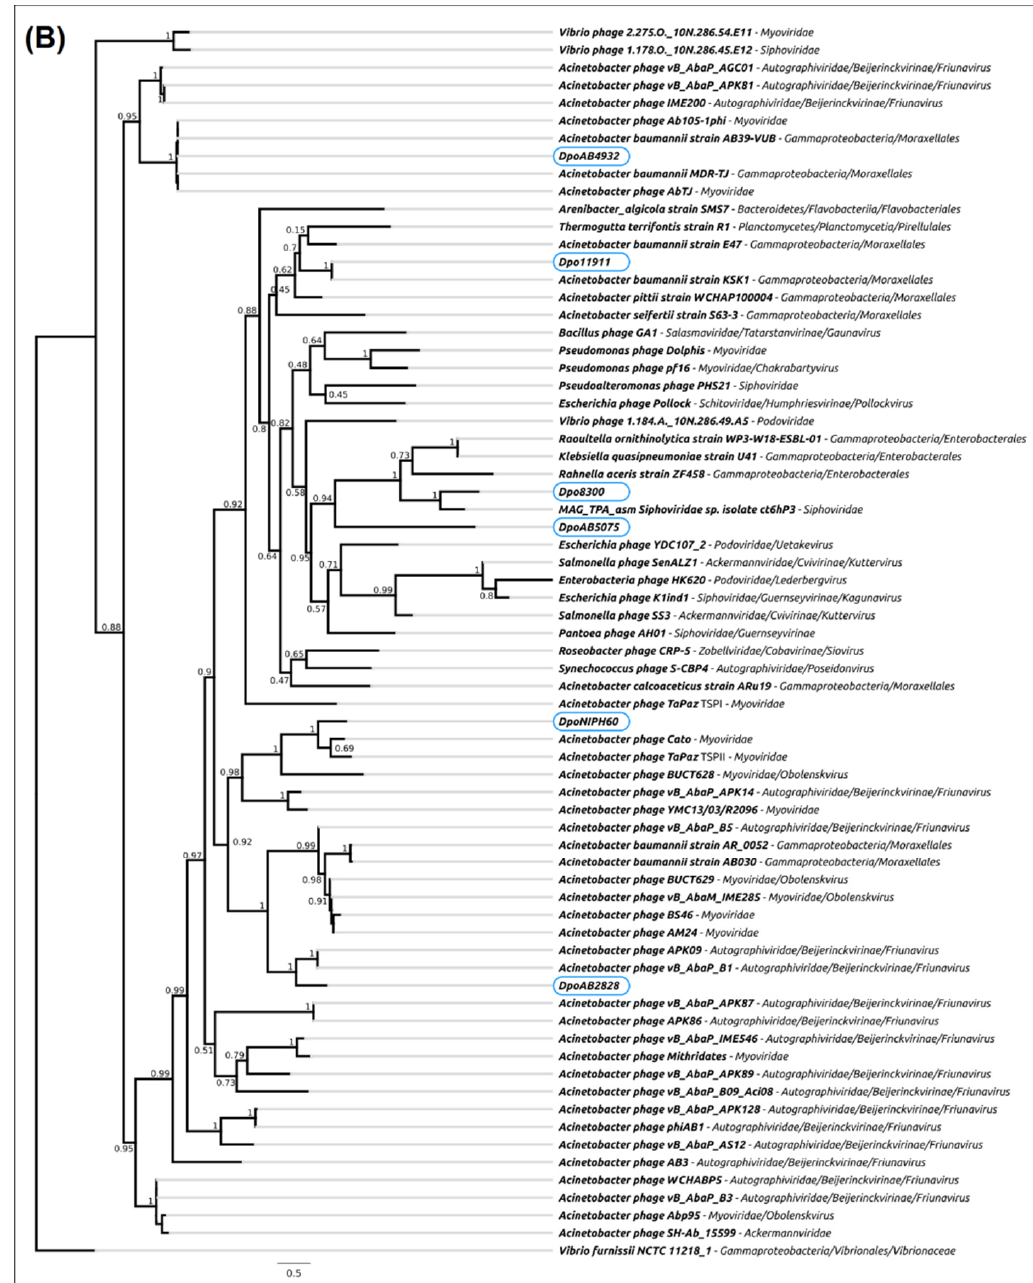
Figure 4. Best-scoring phylogenetic trees constructed with RAxML-NG based on the protein se- quences of the studied prophage-derived depolymerases and homologous sequences found in NCBI nr/nt database. ( A ) The tree built with the N-terminal parts of the proteins (part 1 in Figure 3). ( B ) The tree built with CPS-recognizing/degrading parts of the proteins (combined parts 2 and 3 in Figure 3). Bootstrap support values are shown above their branch as a share of 1000 replicates. The scale bar shows 0.5 estimated substitutions per site. Vibrio furnissii NCTC 11218_1 was used as an outgroup.